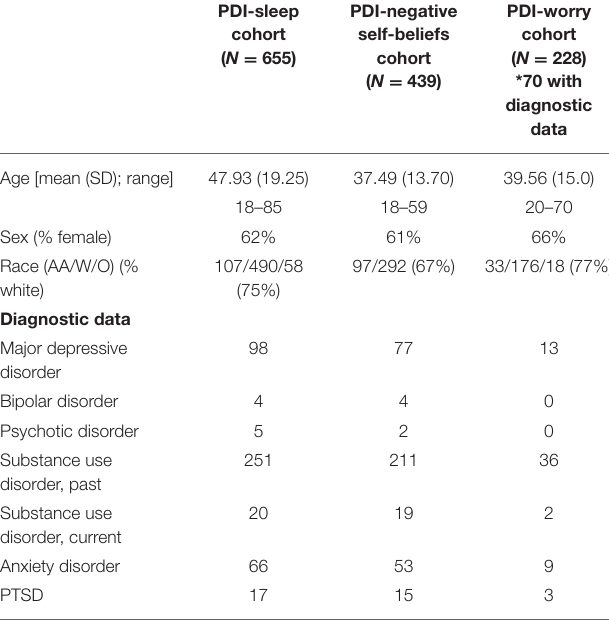
TABLE 1 | Participant